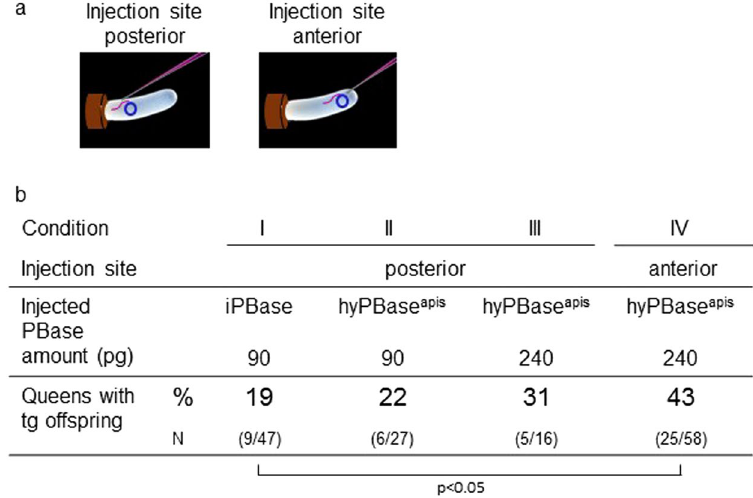
Figure 1. Transformation rates of honeybee queens using different transposases (iPBase and hyPBase apis ), transposase mRNA concentrations and injection sites. Honeybee embryos were injected at either the posterior or the anterior site ( a ) with 90 pg or 240 pg of iPBase and hyPBase apis encoding mRNA and piggyBac plasmid. Genetic transformation was tested by amplification of the transgene via PCRs in male (drone) offspring ( b ). P is shown for fisher’s exact test for the significant difference only.